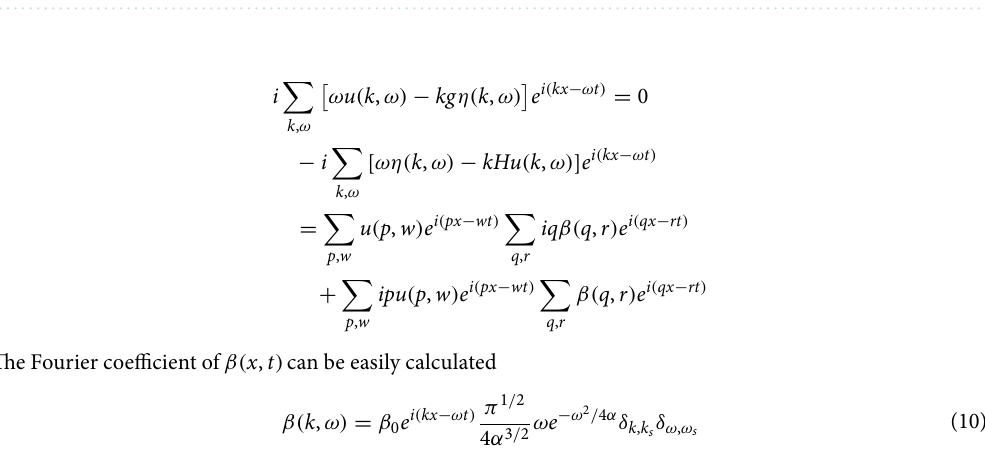
Table 3. Temperature fluctuations observed vs modelled for the Kobe